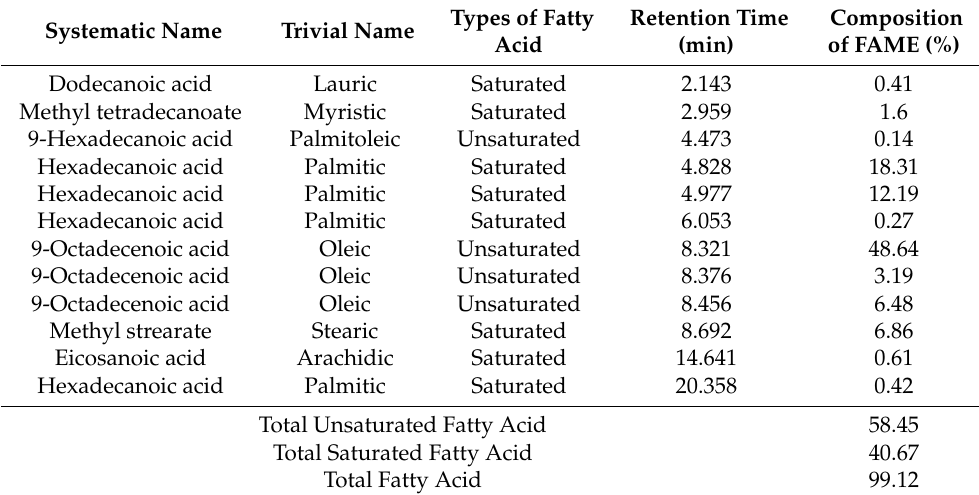
Table 4. Data of GC-MS results for crude